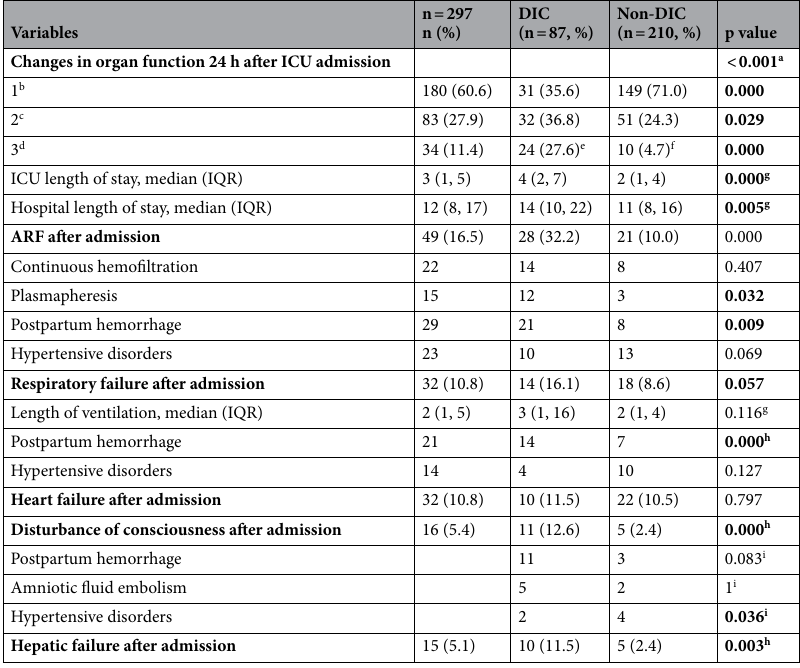
Table 2. Organ failure of patients with DIC admitted to the ICU for obstetric diseases from 2008 to 2016. Significant values are in bold. IQR, interquartile range; ARF, acute renal failure. a Represents the chi-square for trend value. b 1, defined as no organ failure occurring before discharge or improved organ function with a SOFA score less than or equal to 1. c 2, defined as single organ function with a SOFA score greater than or equal to 2. d 3 indicates that MODS did not improve until 24 h after ICU admission or that death occurred before discharge. e There were four deaths in the DIC group. f There were two deaths in the non-DIC group. g Represents value from the Mann–Whitney U test. h Represents the continuity correction. i Represents the value from Fisher’s exact